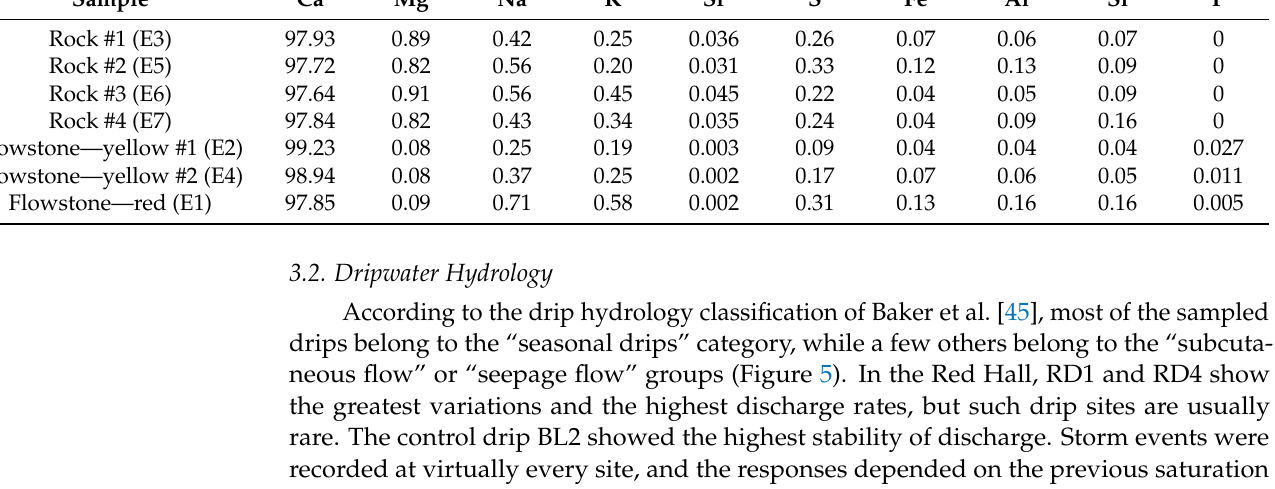
Table 1. Elemental composition of the surface features of a rock sample containing corrosion cups. The units are the mass percentage per sample. The labels E1–E7 correspond to the ones shown in Figure 4.